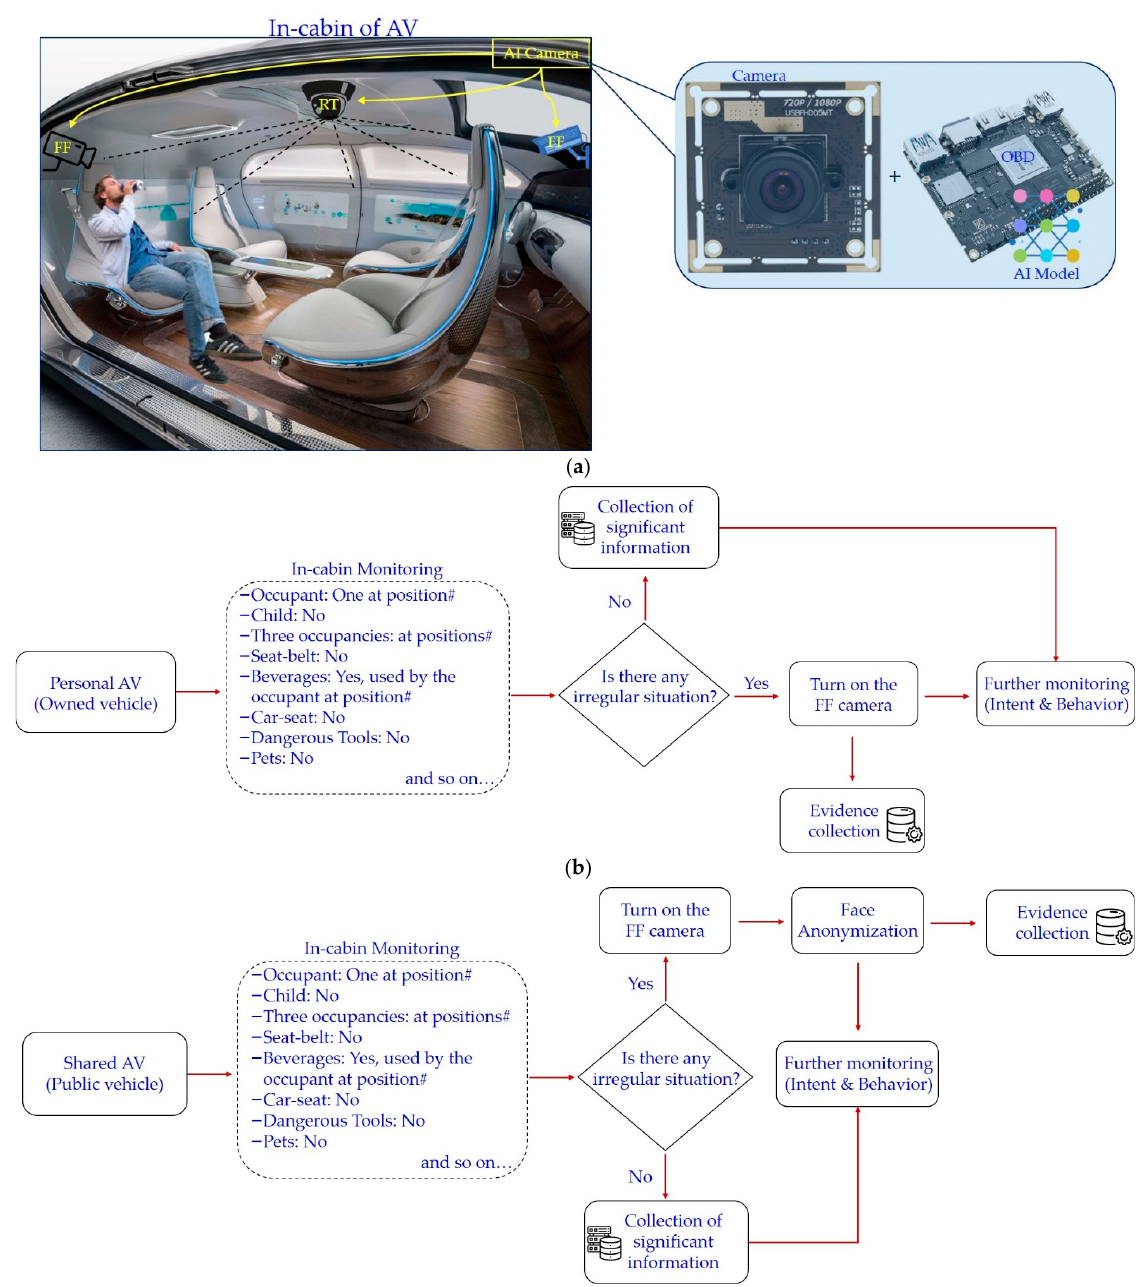
Figure 12. The proposed IMS for level 4 and beyond AVs: ( a ) Setup of proposed IMS; ( b ) IMS for personal AV (i.e., owned vehicle for personal use only); ( c ) IMS for shared AV (i.e., public vehicles or transport vehicles). Here, FF: Front-facing monitoring camera; RT: Rooftop monitoring camera. An AI camera is installed at the center of the vehicle such that the entire vehicle can be monitored in a single shot. It is equipped with a camera and an AI-assisted onboard